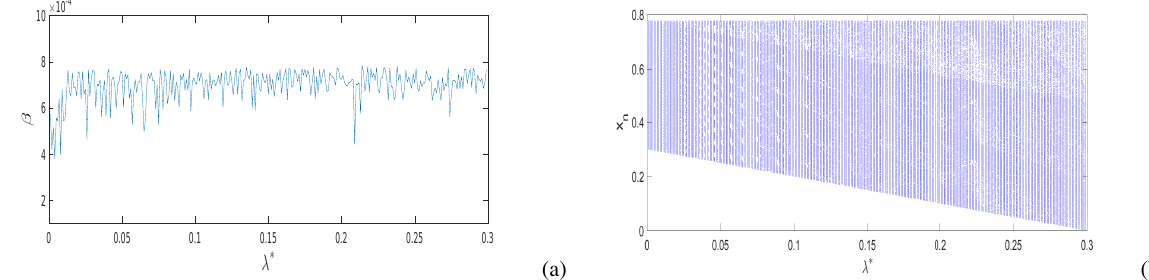
Fig. 3 (a)Graph of the Lyapunov exponent of the map (2) with respect to the parameter λ ∗ , where x b = 0 . 3, λ = 3 . 7, (b)Bifurcation diagram of (2) with respect to the parameter λ ∗ , where x b = 0 . 3, λ = 3 . 7.